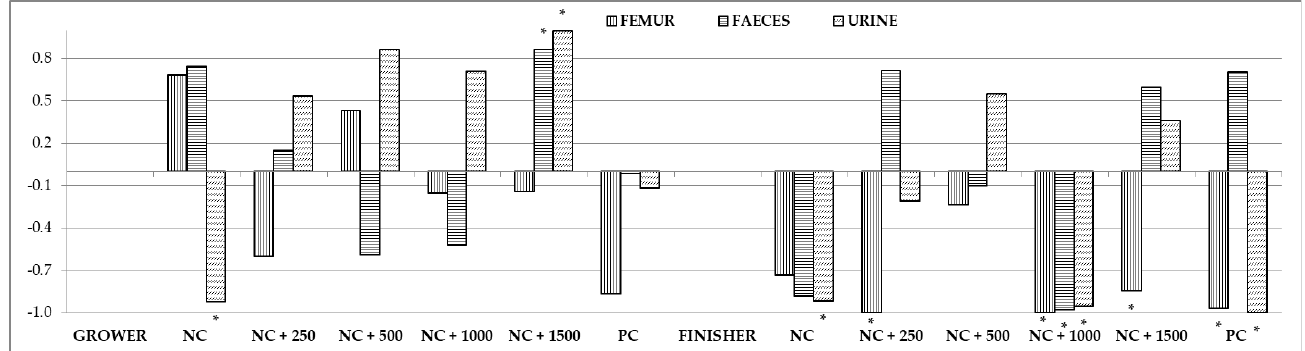
Figure 3. Correlations between content of calcium in the chyme and in the blood, femur, feces, and urine. Asterisks indicate significant correlations at p < 0.05.